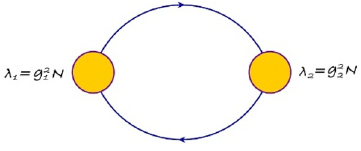
Figure 1 . Two-node